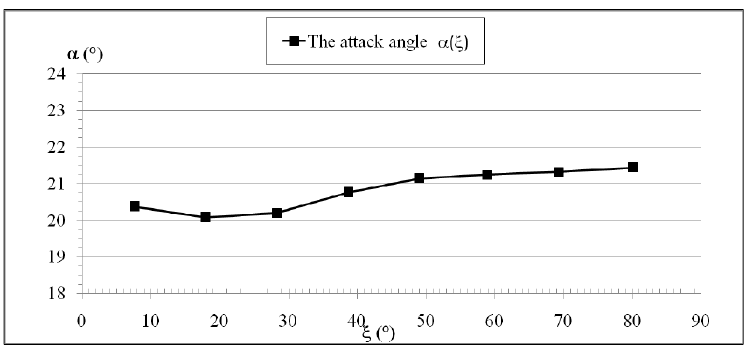
Figure 11. The attack angle α at the impeller’s inlet.